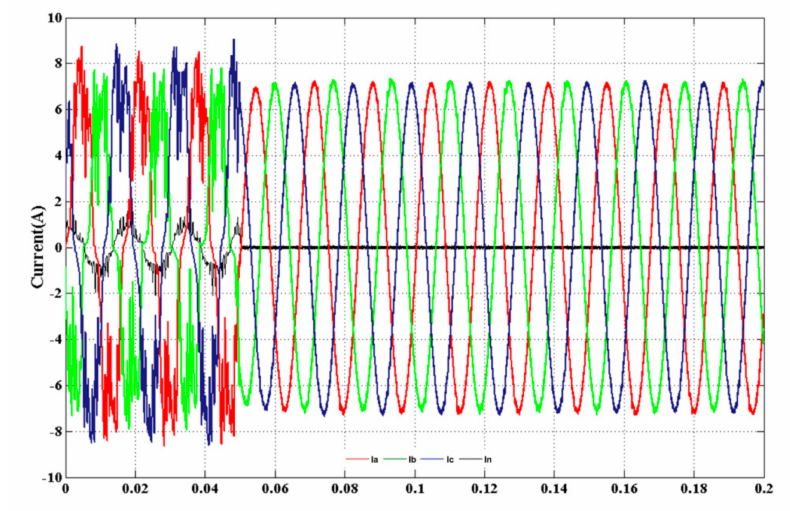
Figure 14. Experimental result of the FNN for case 2.